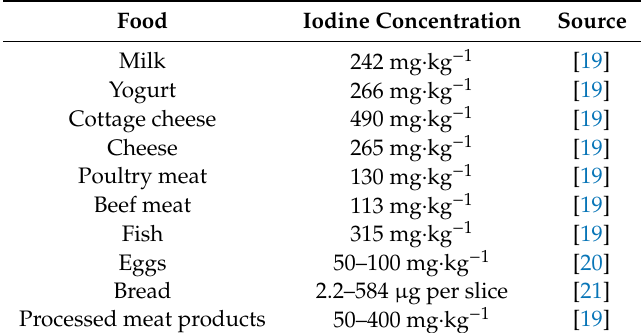
Table 3. Iodine content is selected foodstu ff